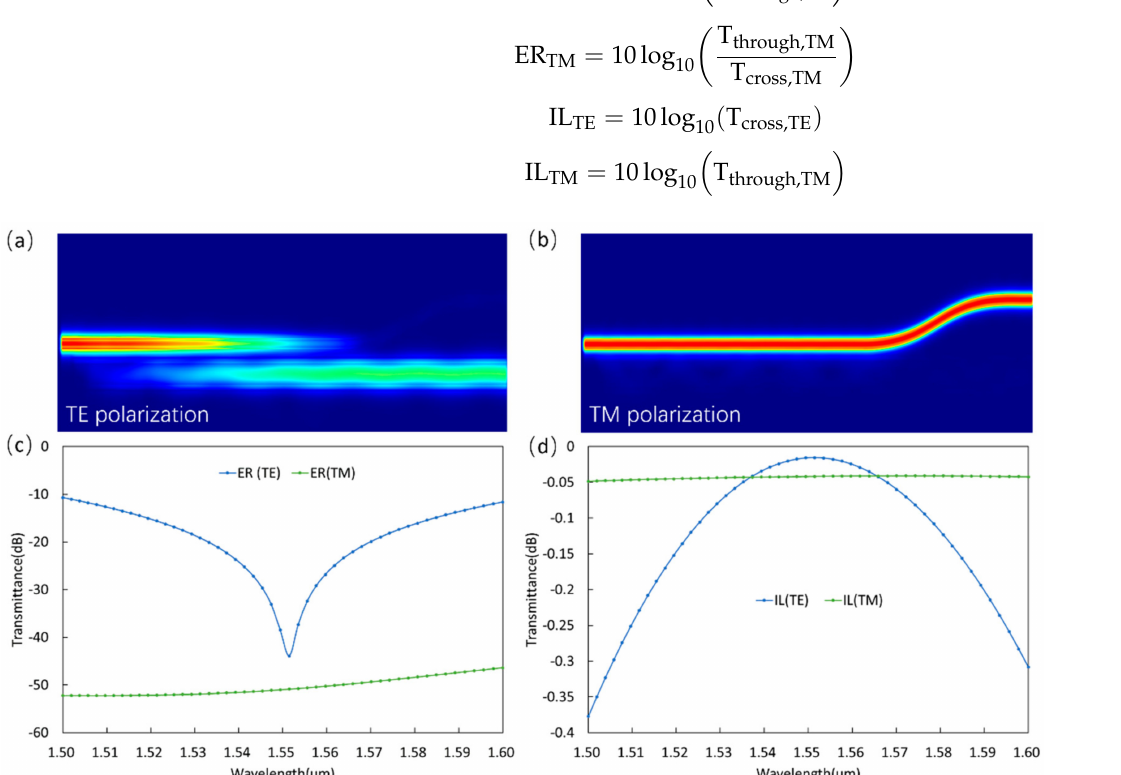
Figure 4. Light propagation profiles of ( a ) TE polarization and ( b ) TM polarization at the wavelength of 1550 nm; ER and IL of ( c ) TE polarization and ( d ) TM polarization as wavelength varies. T through and T cross are the through port and cross port transmission,